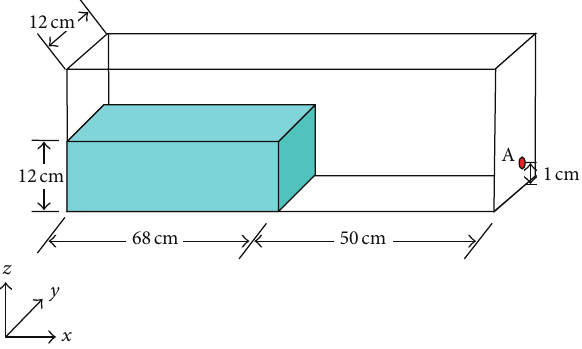
Figure 2: Schematic sketch of the dam-break simulation corre- sponding to